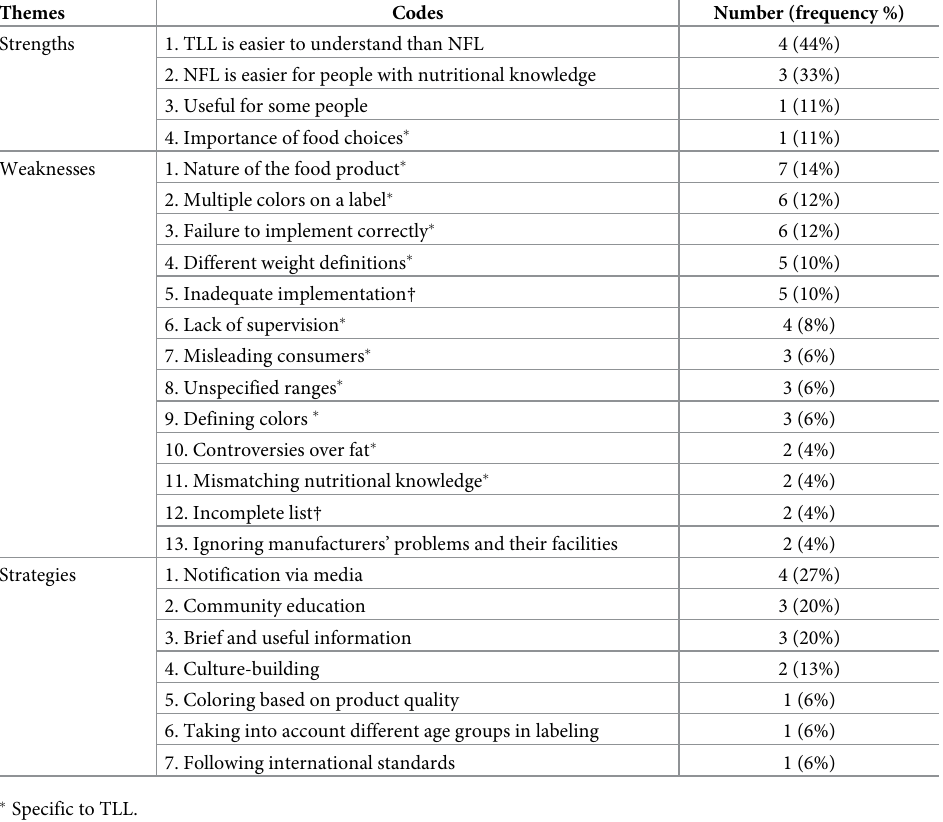
Table 5. Strengths, weaknesses and strategies for improving the use of nutrition labels, based on nutritionists and food industry experts’ opinions. Themes Codes Number (frequency %)